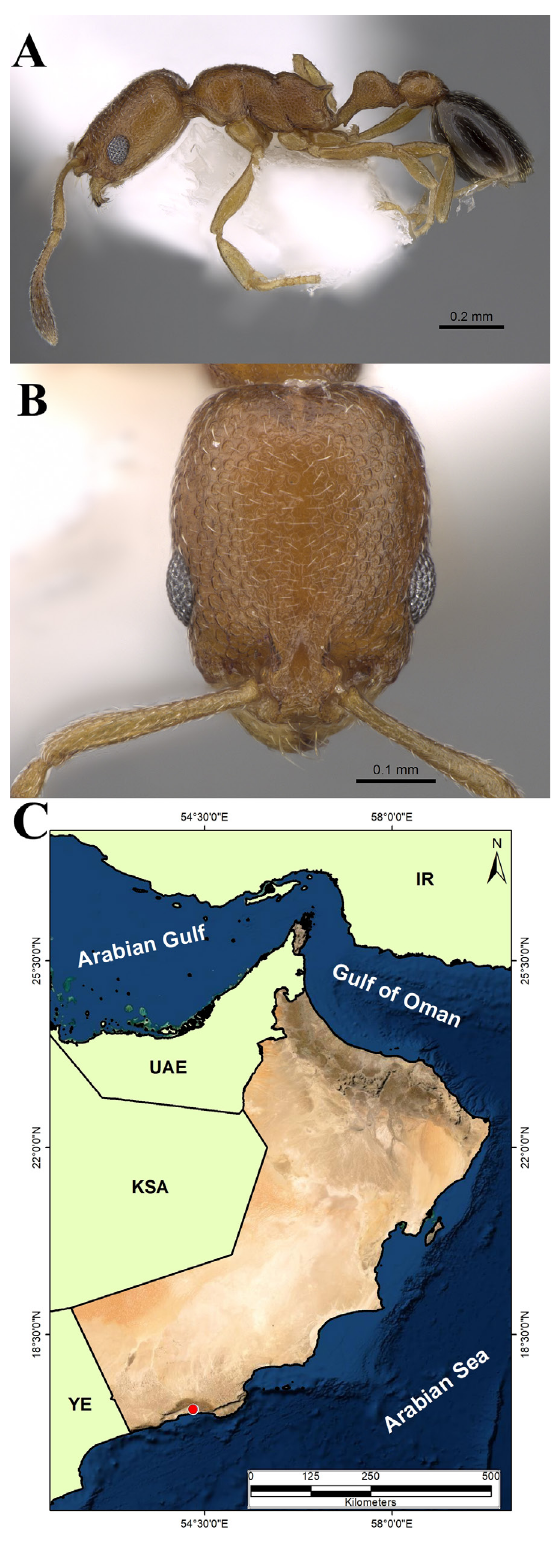
Fig. 27. Cardiocondyla wroughtonii (Forel, 1890), worker (CASENT0922871, AntWeb.org (Michele Esposito)). A . Body in profile. B . Head in full-face view. C . Distribution